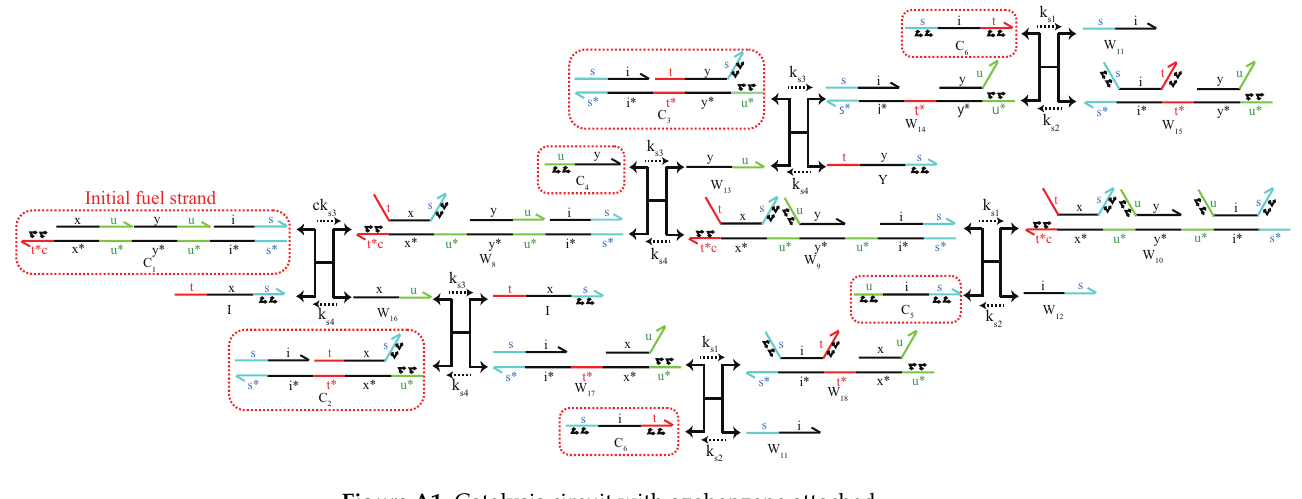
Figure A1. Catalysis circuit with azobenzene attached.